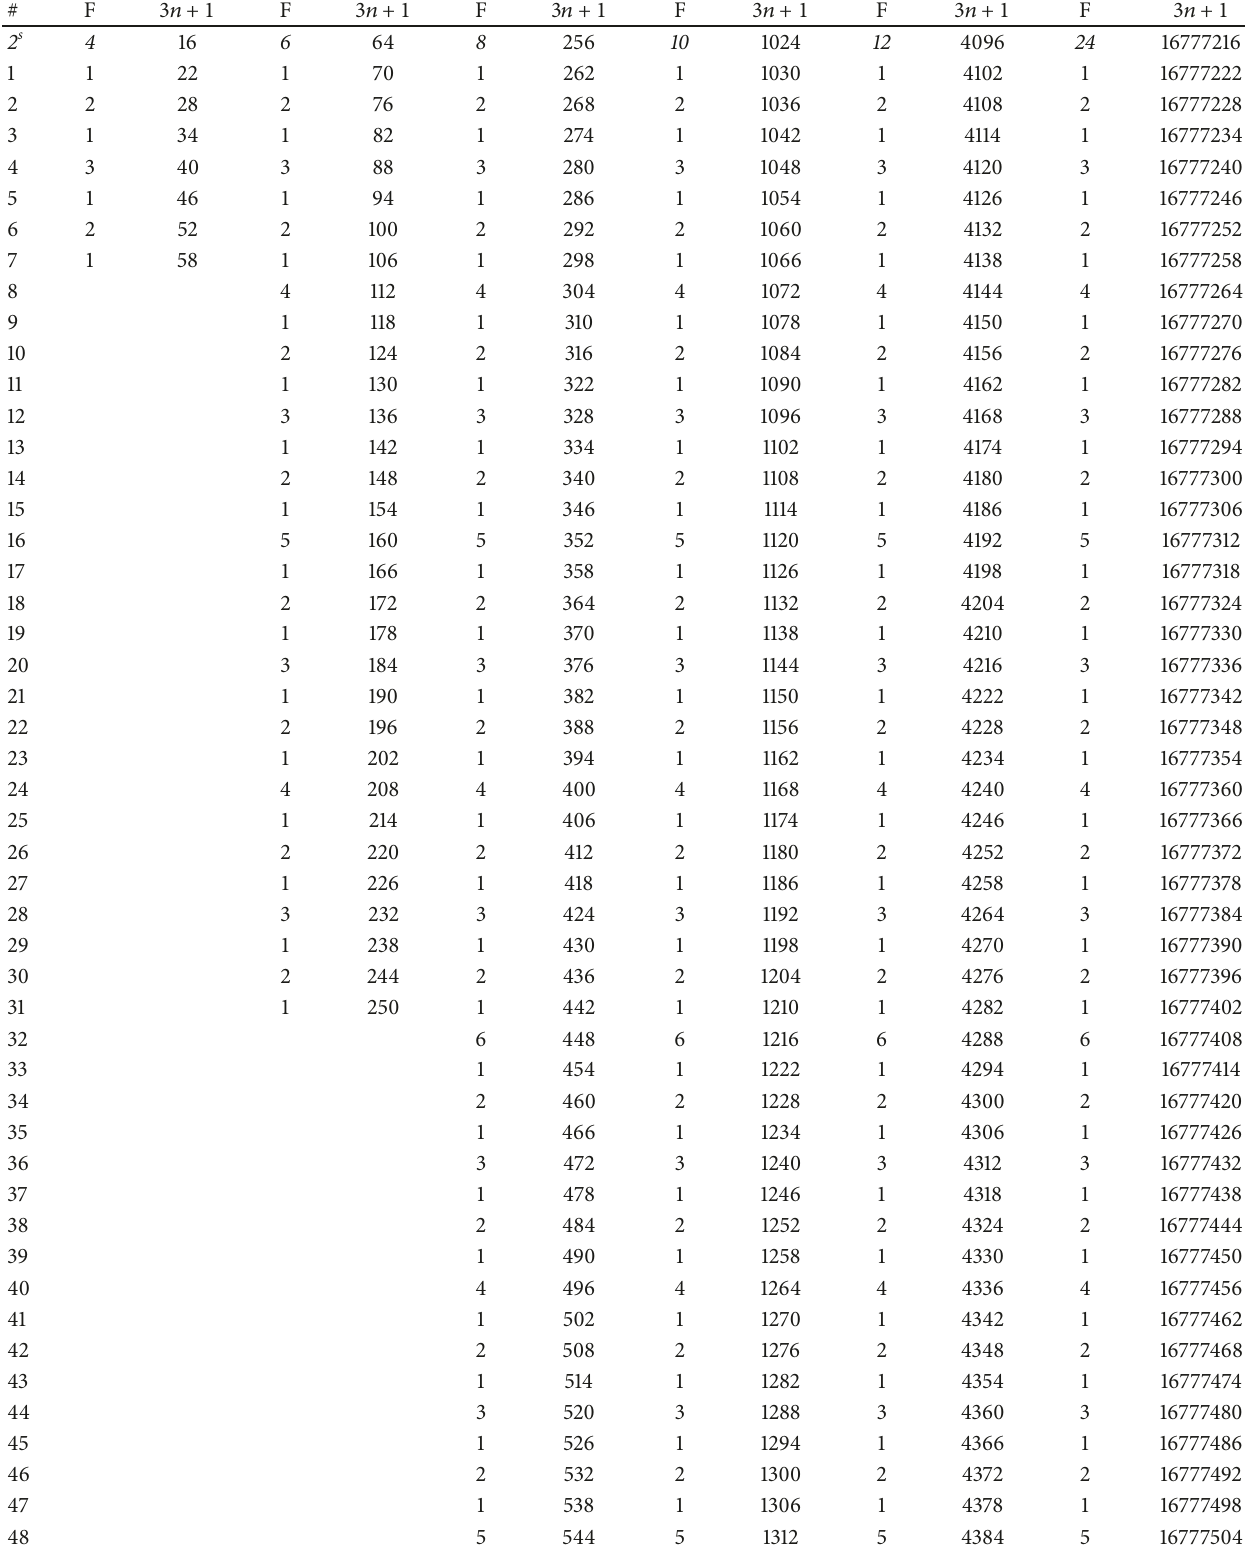
Table 3: Representative of symmetrical RFs in the table of 3𝑛 + 1 even